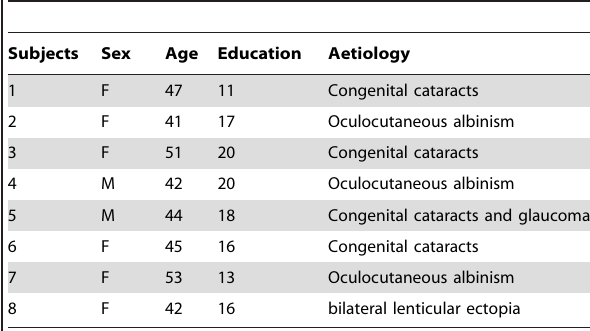
Table 2. Description of blind subjects with residual vision (BRV; Experiment 1).